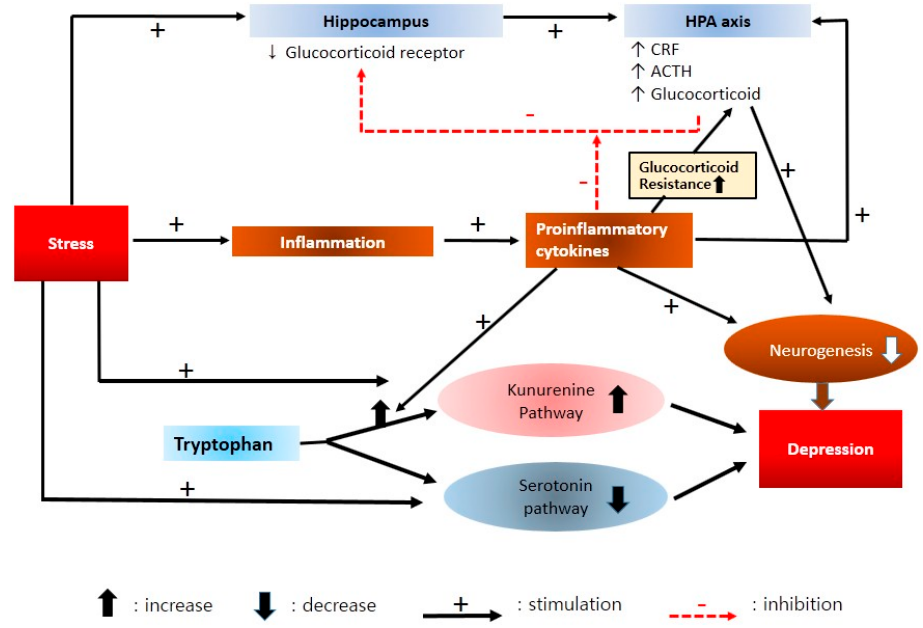
Figure 4. Neuroendocrine and neuroimmune interactions in depression.